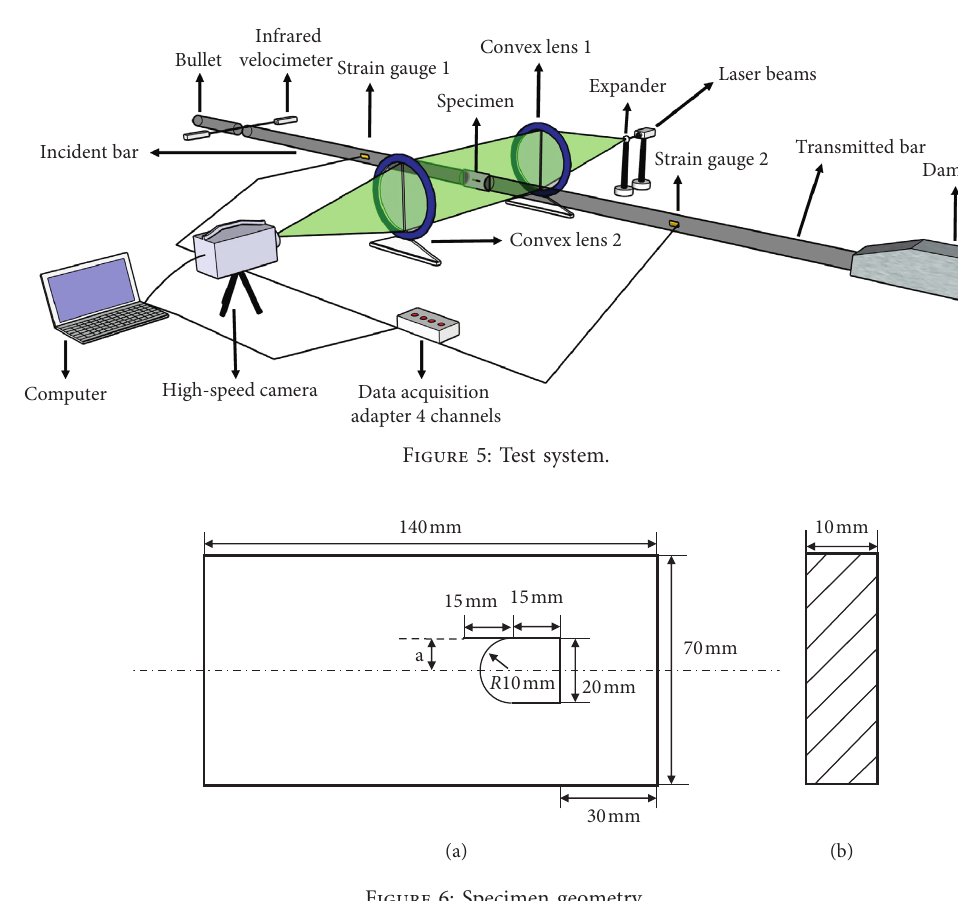
Figure 6: Specimen geometry.